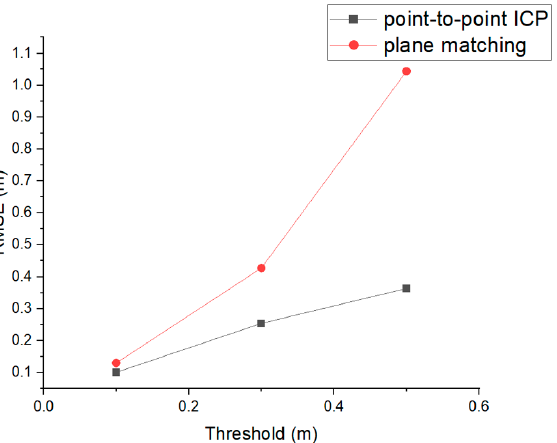
Figure 12. Registration RMSE of two algorithms according to the thresholds of 0.1, 0.3, and 0.5.